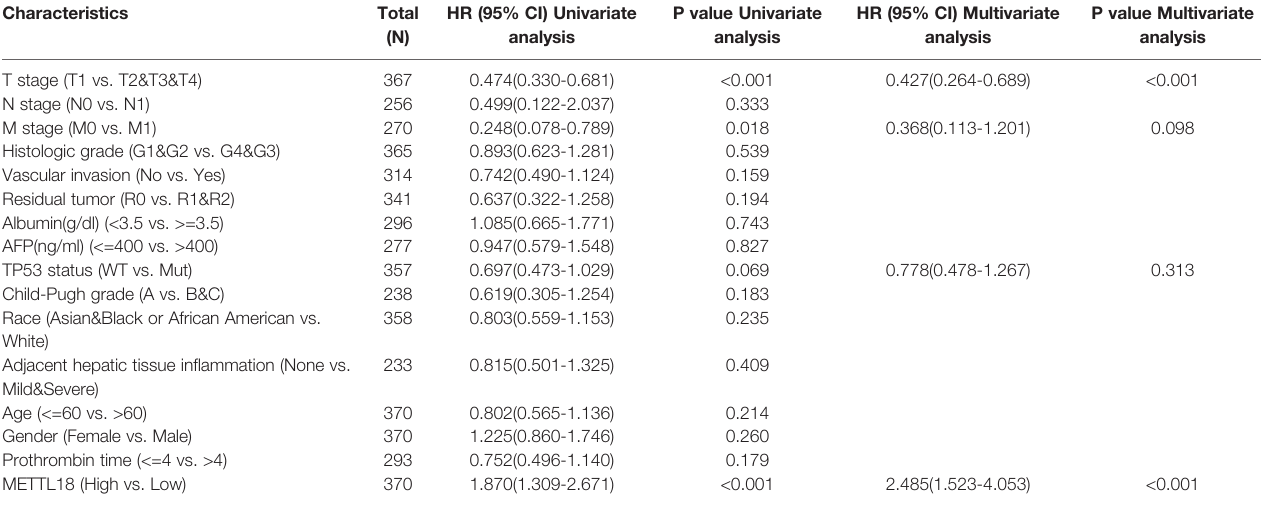
TABLE 3 | Univariate and multivariate survival method (Overall Survival) of prognostic covariates in patients with hepatocellular carcinoma.